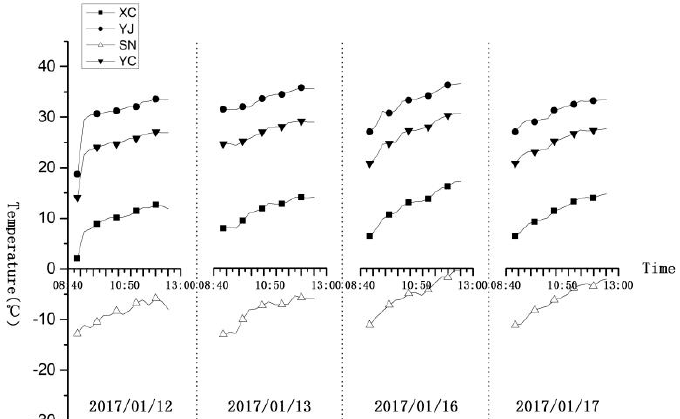
Figure 5. Outdoor device time—temperature change the map outdoor device time—temperature change the map (SN-indoor temperature; YJ-flue gas inlet temperature; YC-flue gas outlet temperature; XC-fresh air outlet temperature; ST-canteens outlet temperature; SW-outdoor air temperature).